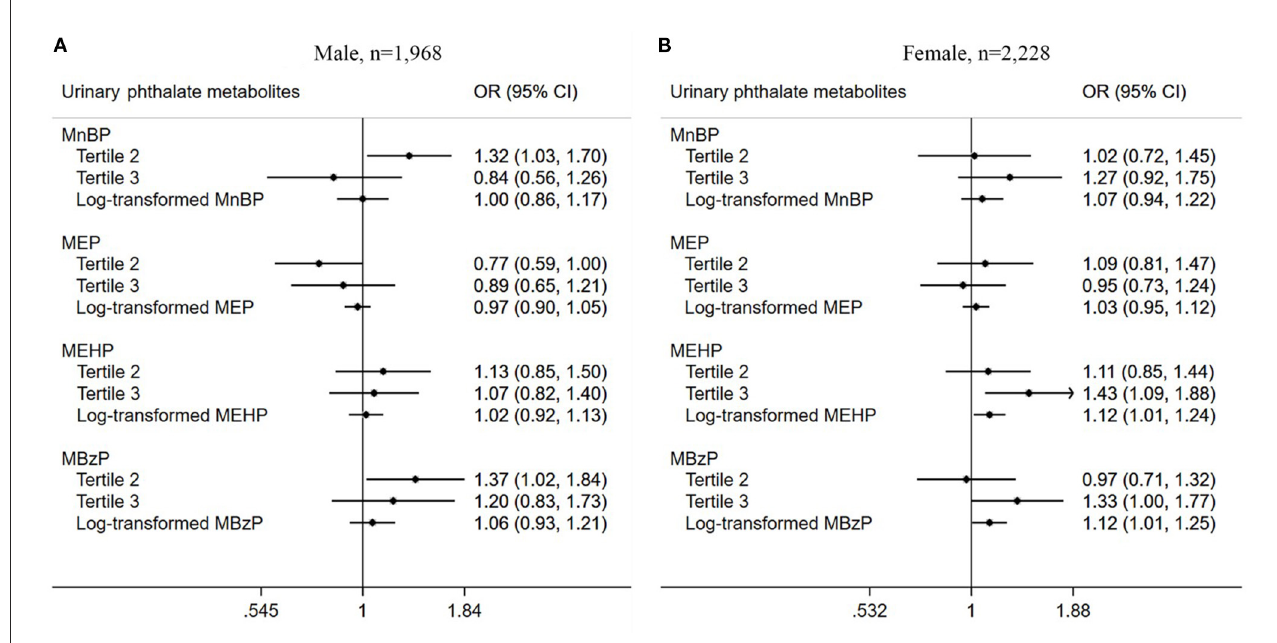
FIGURE2 Association between urinary phthalate metabolites and chronic pain among US adults stratified by gender. (A) Male, n = 1,968; (B) Female, n = 2,228.